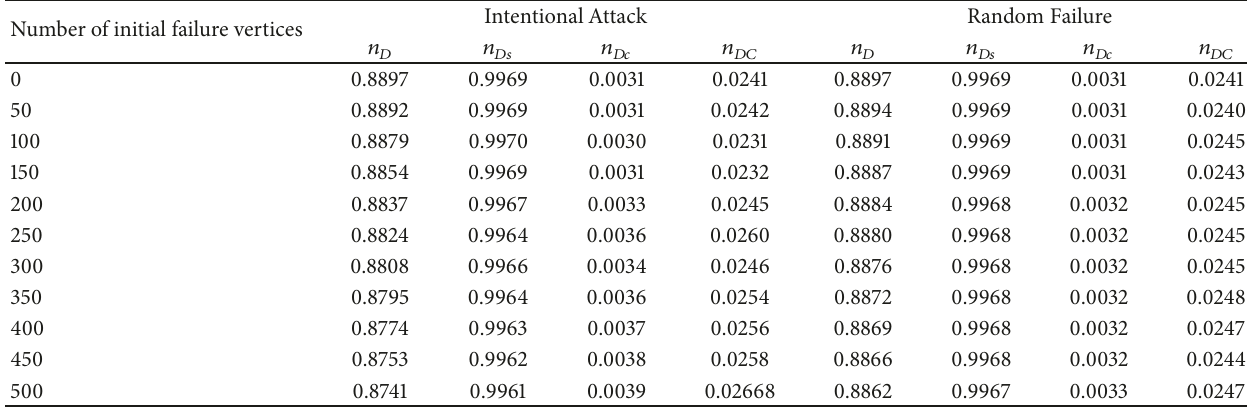
Table 4: Controllability of the shareholding networks under attacks or